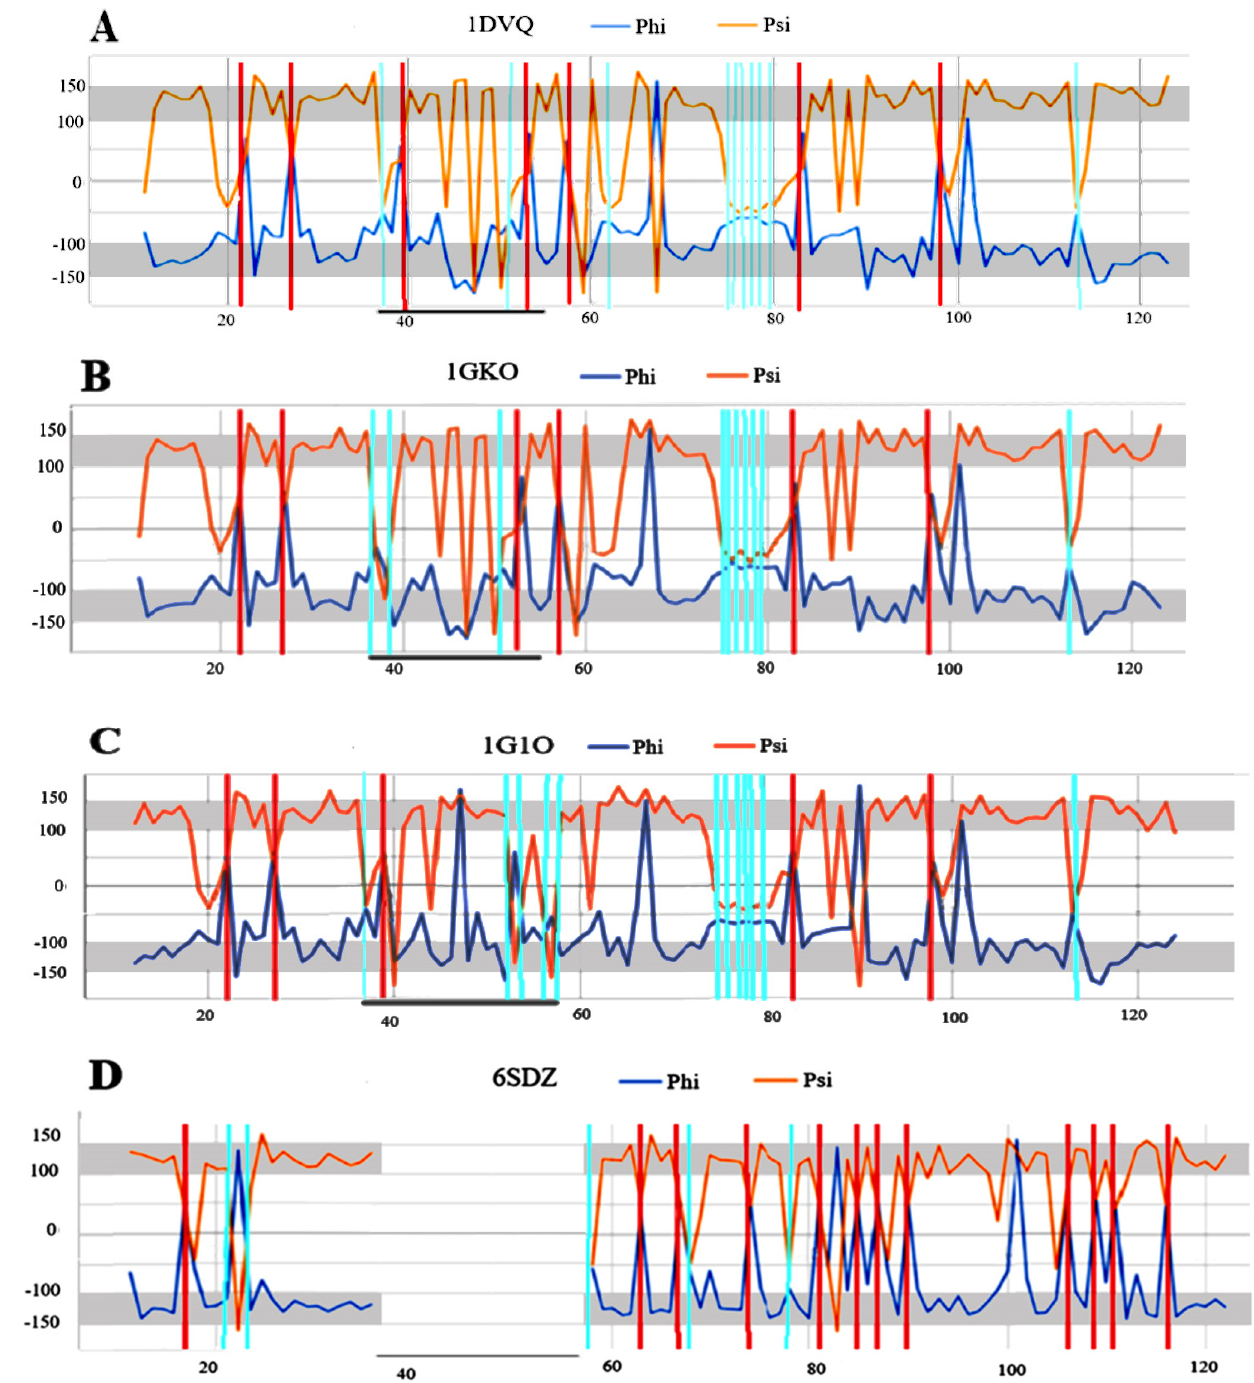
Figure 8. Summary of profiles for the Phi and Psi angles in the transthyretins: ( A )—1DVQ—native form—reference ( B )—1GKO—form resistant to amyloid transformation; ( C )—1G1O—form that undergoes aggressive amyloid transformation ( D )—6SDZ—amyloid form of transthyretin; Vertical lines—cyan—positions with R α conformation; red—helical L α . Horizontal; grey bottom line on ( A – C )—section of chain absent in the amyloid form.